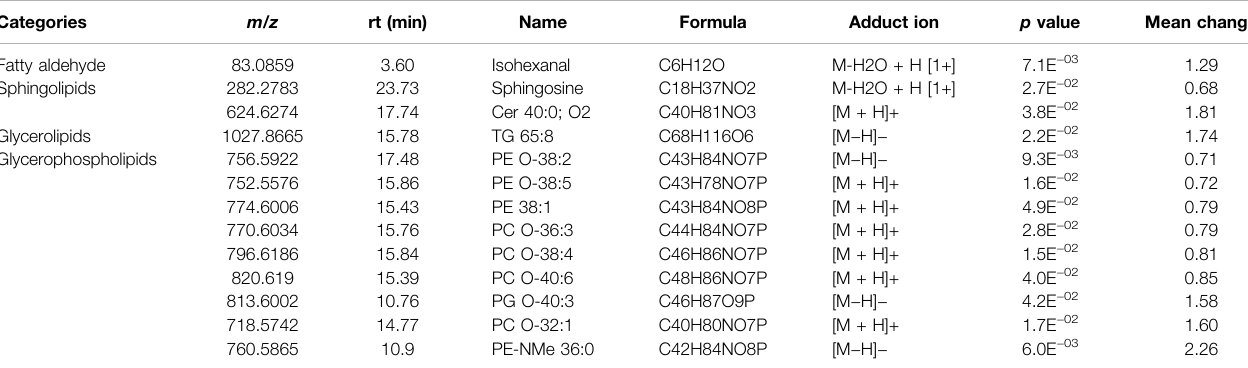
TABLE 3 | Differential metabolites in pregnant women with PROM compared with healthy pregnant women.